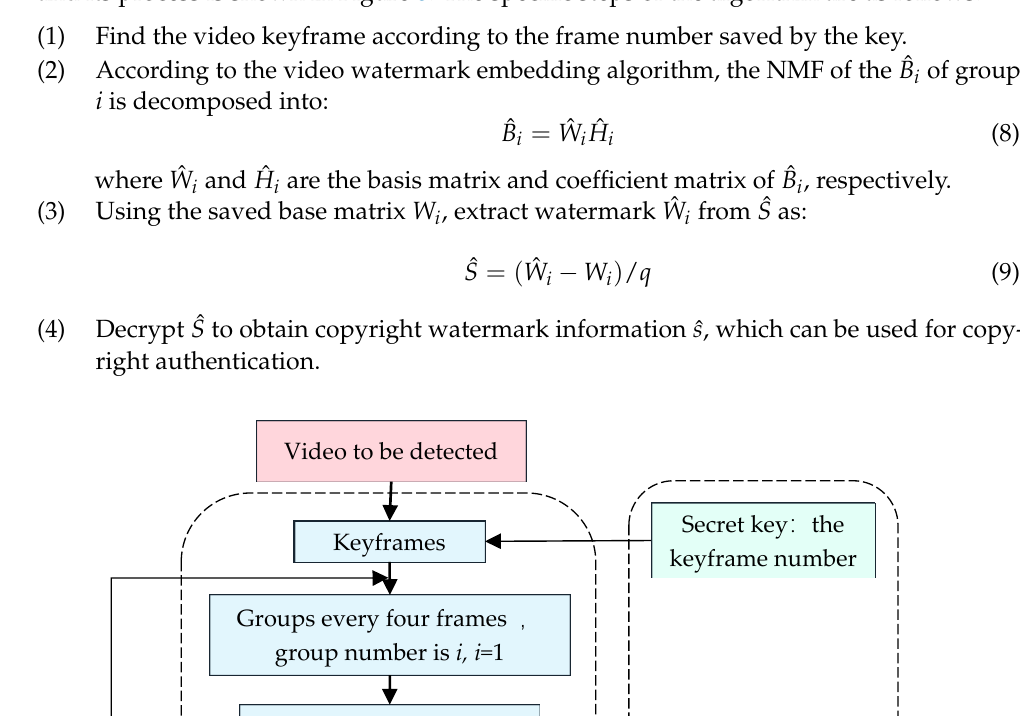
Figure 8. Video watermark extraction flowchart. Figure 9 is an example of the video watermark extraction algorithm. Using a secret